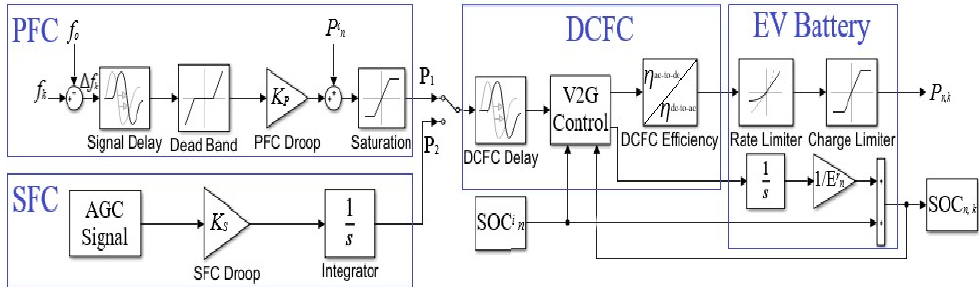
Figure 9. Combined primary and secondary frequency control droop loop and electric vehicle (EV) battery model.